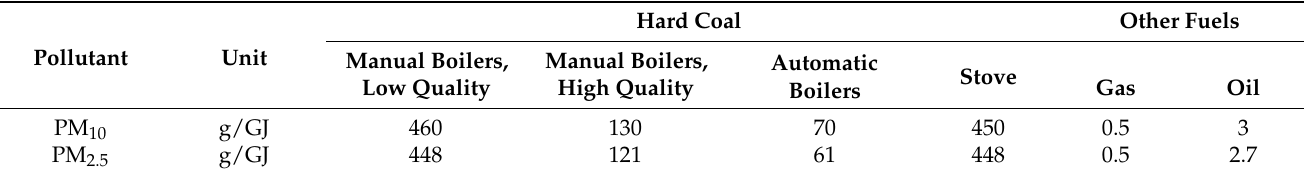
Table 1. Particulate emission factors for household boilers used for Scenarios 1 and